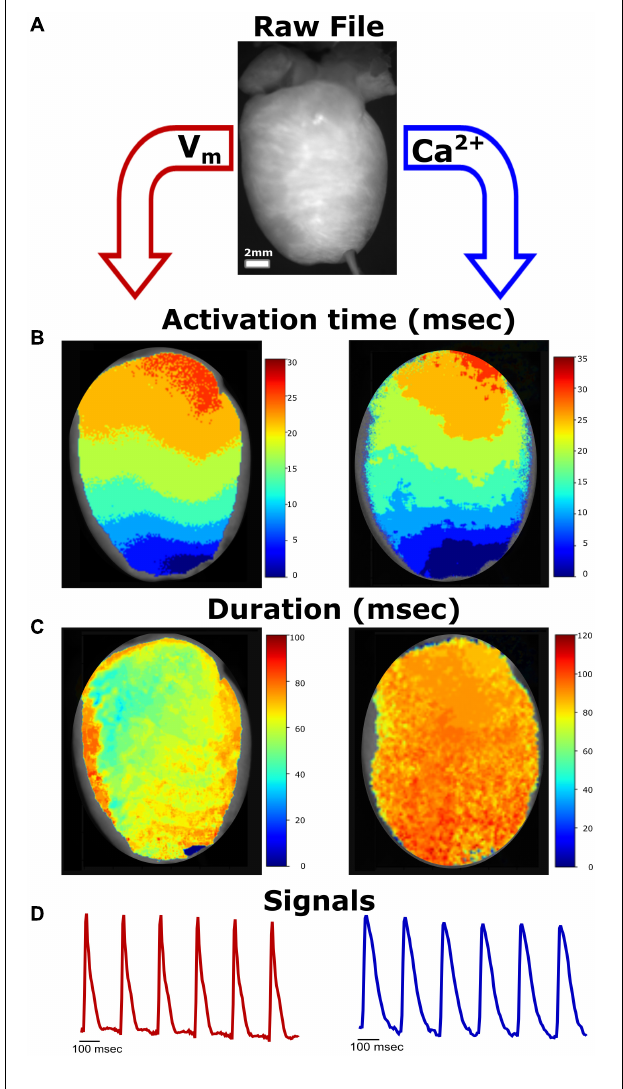
FIGURE 1 | Simplified Workflow. (A) Representative raw image file from a Langendorff-perfused rat heart study (*.tif stack). Image properties (e.g., frame rate) are defined by the user. In our experimental setup, voltage and calcium signals can be analyzed from the same heart preparation. (B) Activation maps generated from raw image file demonstrate propagation away from the pacing electrode at the apex (left—voltage, right—calcium). (C) Generated action potential duration (left) and calcium transient duration (right) maps. (D) Representative traces from the raw image